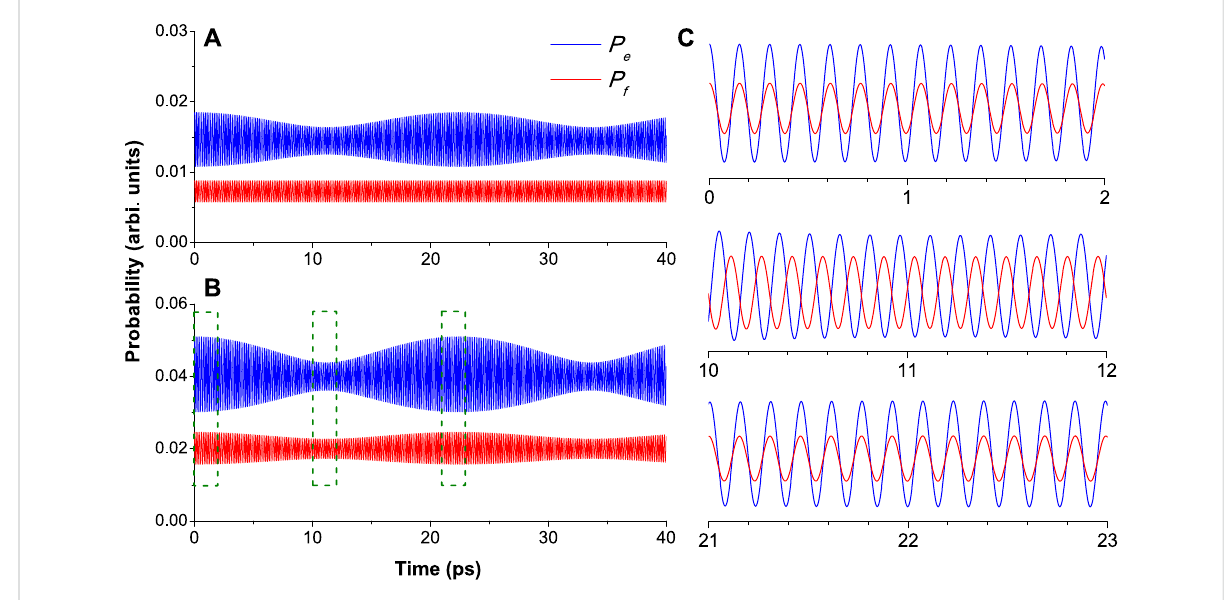
FIGURE 4 (A) Probabilities of fi nding atoms on level | e 〉 ( P e )and level | f 〉 ( P f ) plotted from analytical expressions up to second-order terms. (B) Same probabilities plotted with the expressions up to fourth-order terms. The envelope modulation of P f is a result of multi-photon ( > 3) interaction between levels | c 〉 and | f 〉 because single-photon transition is forbidden. (C) Probabilities zoomed in 2-ps windows, and thecurveshave been offset to show a relative phase shift due to different beat frequencies of the signals. Parameters used for the plots are: α p Ω ( 0 ) p (cid:2) 0 . 2, α c Ω ( 0 ) ae (cid:2) 0 . 6, (cid:4)(cid:4) √ (cid:4)(cid:4)(cid:4)(cid:4) √ (cid:4)(cid:4)(cid:4) √ Ω ( 0 ) (cid:2) Ω ( 0 ) 2 , Ω ( 0 ) ce (cid:2) 0 . 2 Ω ( 0 ) ae , Ω ( 0 ) df (cid:2) Ω ( 0 ) ce 5/9 , and Ω ( 0 ) de (cid:2) Ω ( 0 ) ce 1/9 . Relative transition dipole moments are estimated by the sum rule ae / af